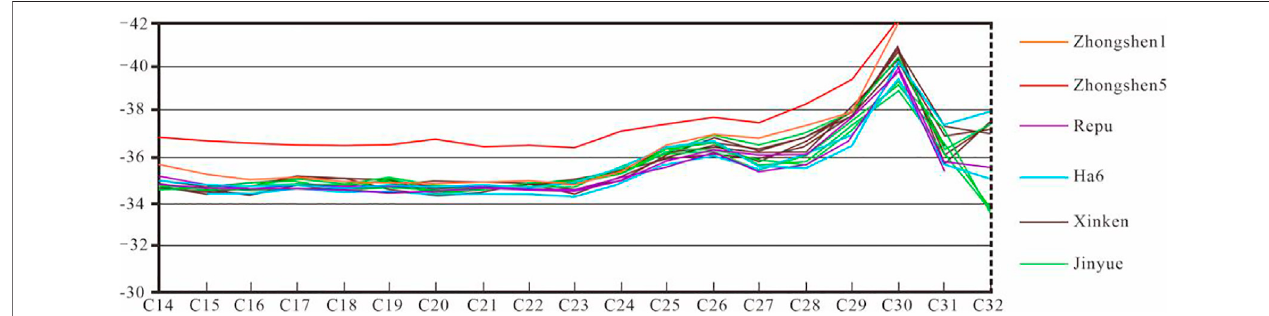
FIGURE 9 | Distribution of carbon isotopes of crude oil monomer hydrocarbon in the Halahatang Area.